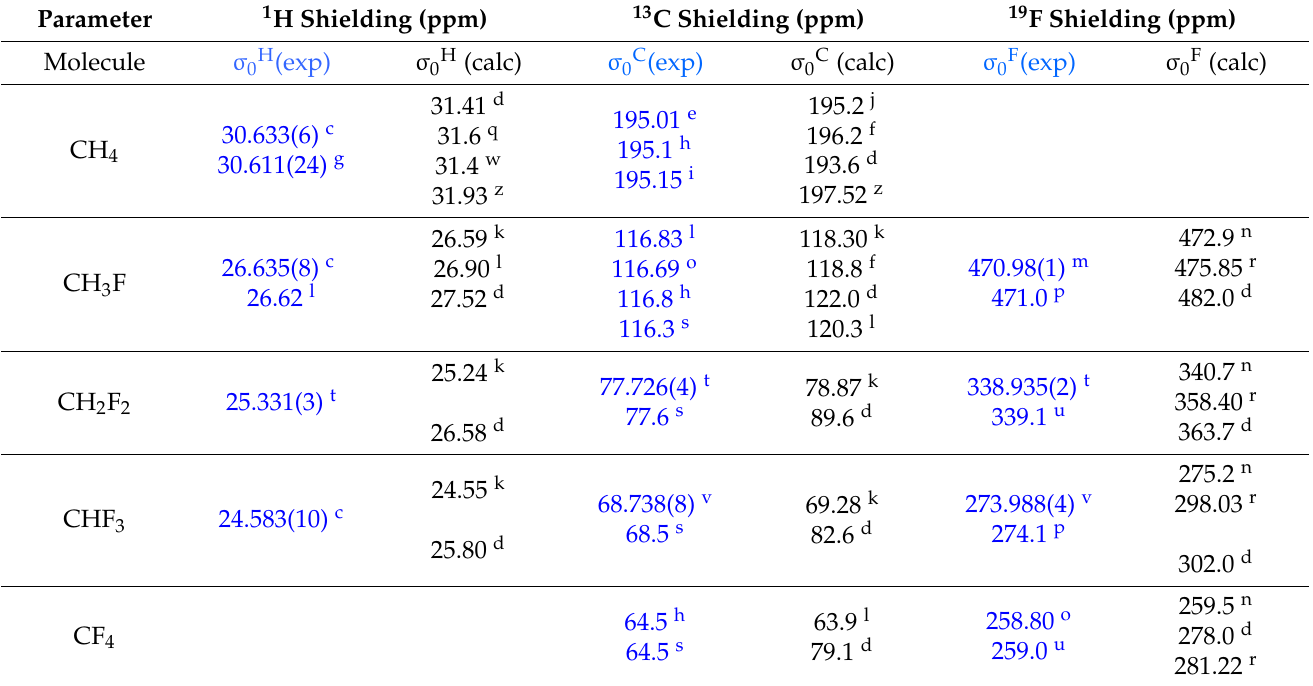
Table 2. Selected shielding constants for CH4-nFn isolated molecules available from gas-phase NMR experiments a and advanced ab initio calculations of quantum chemistry b .